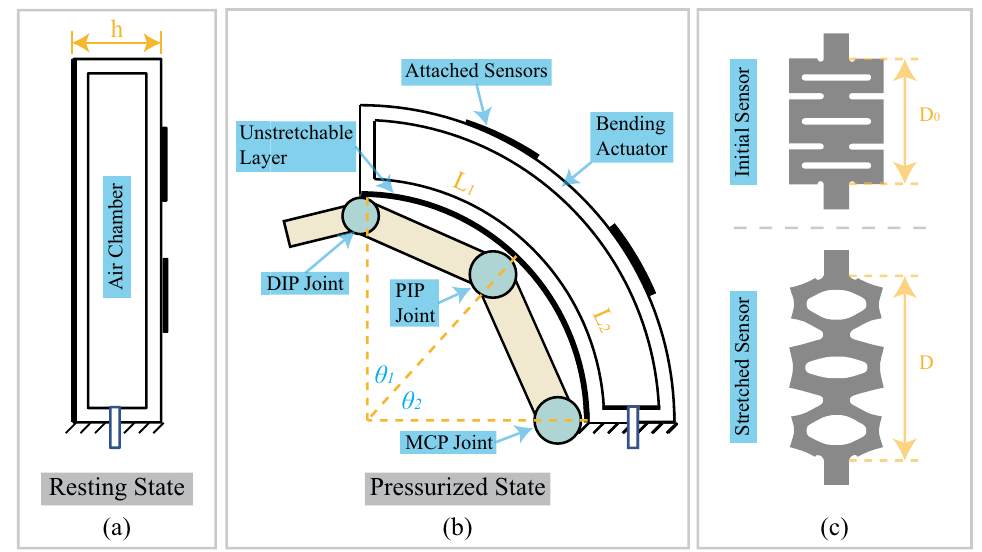
Figure 4. Kinematic description of the bending actuator and kirigami-inspired flexible sensors. ( a ) Bending actuator at resting state; ( b ) bending actuator in a pressurized state with a schematic diagram of the finger model; ( c ) schematic diagram of the initial sensor pattern and the stretched sensor pattern.